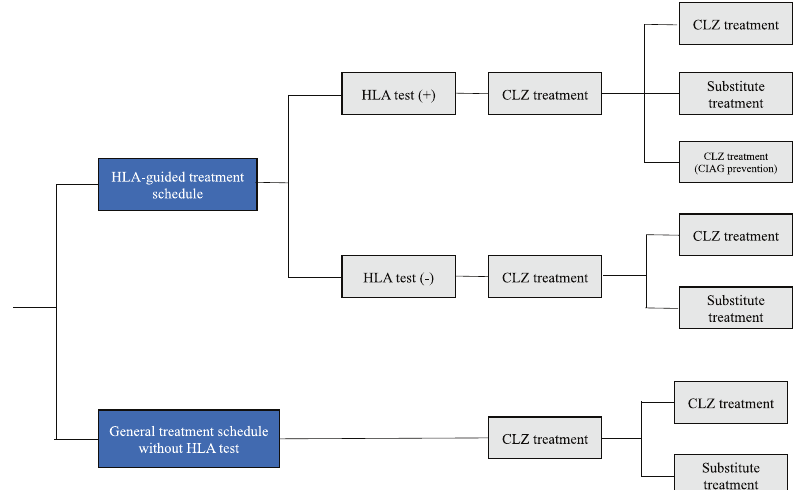
Fig. 1 Decision tree schematic. The “ general treatment schedule without HLA test ” compared with the “ HLA-guided treatment schedules ” . CIAG clozapine-induced